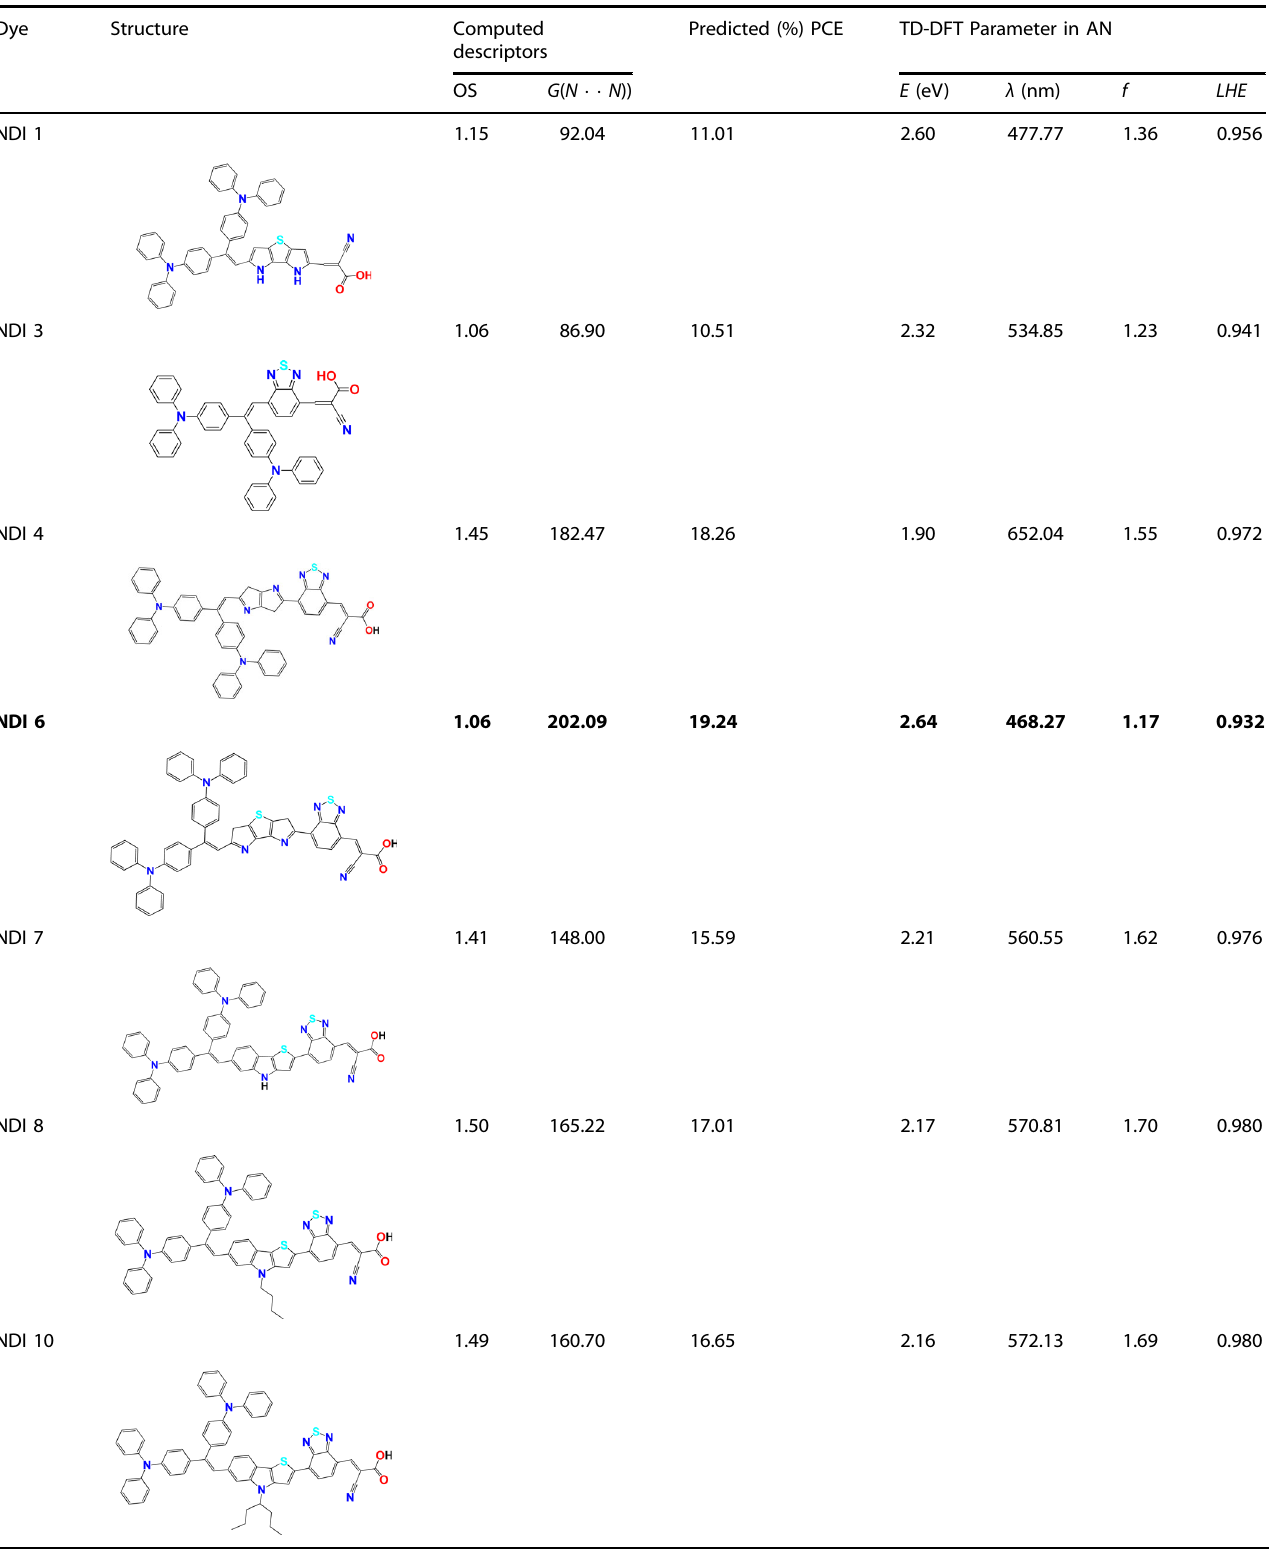
Table 3. Calculated descriptor, predicted %PCE and TD-DFT parameter [excitation energy ( E ), wavelength ( λ ), oscillator strengths ( f ), and light harvesting ef fi ciency (LHE) in acetonitrile (AN) media] of the designed N,N ′ -dialkylaniline